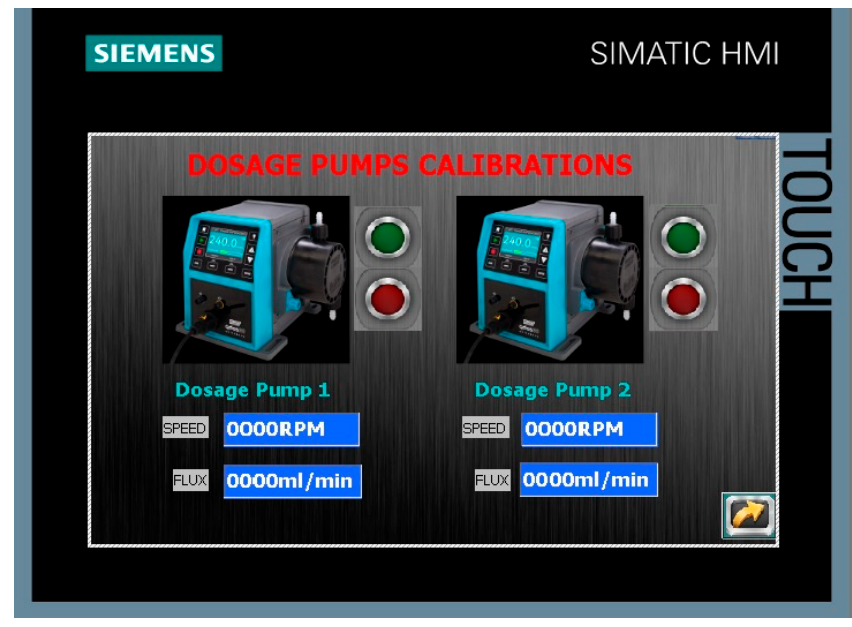
Figure 8. Screen to calibrate the dosage pumps in the HMI.